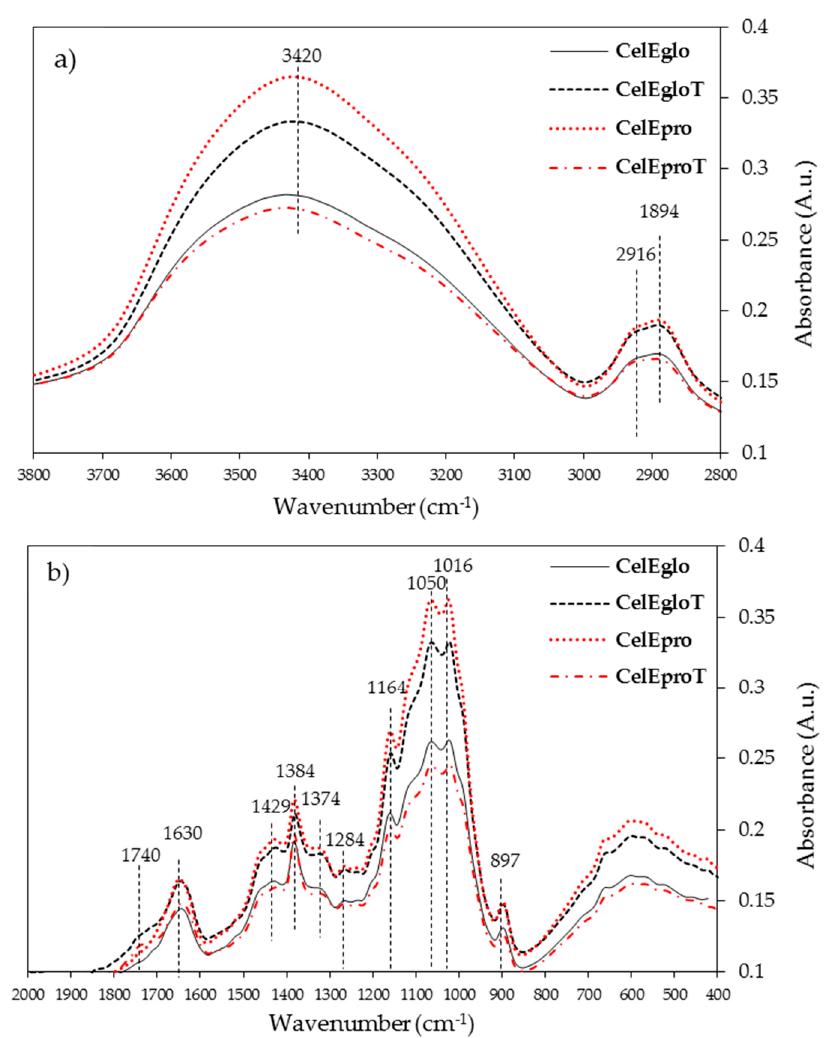
Figure 4. FTIR spectra of the isolated celluloses depicted in the region 3800–2800 cm − 1 ( a ) and in the region 1800–600 cm − 1 ( b ). The samples designations are the same as in Tables 2 and 3.